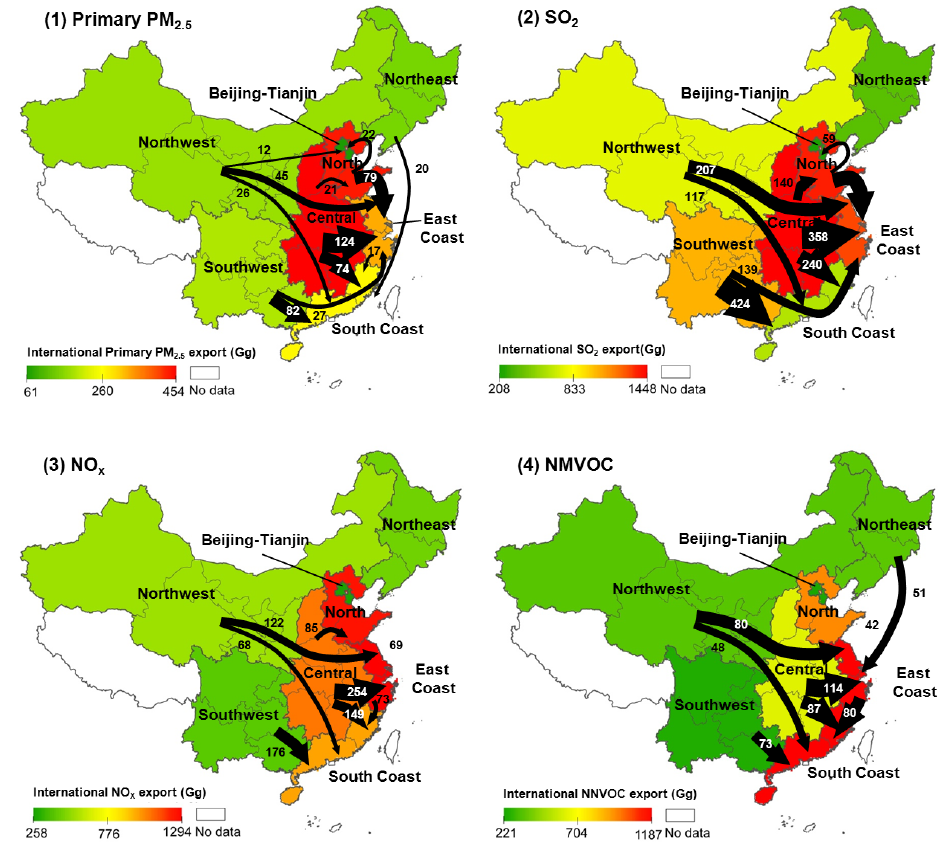
Figure 6. Regional pollutant emissions due to production of intermediate products to support other regions’ international exports (unit of flow: Gg). The shading from green to red indicates each region’s total international pollutant